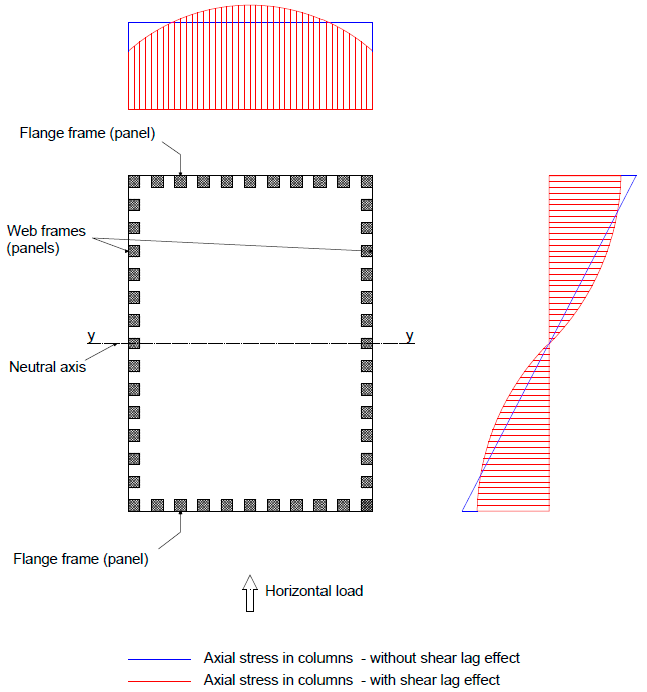
Figure 2. Shear lag effect in a tube structural system (negative shear lag effect).